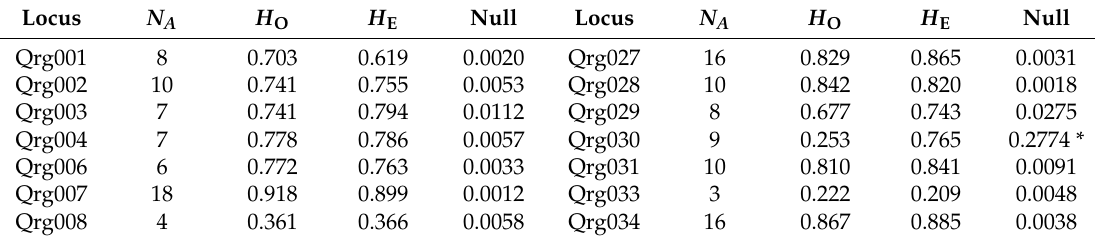
Table 2. Genetic parameters for 46 microsatellite loci across all samples developed for Quercus